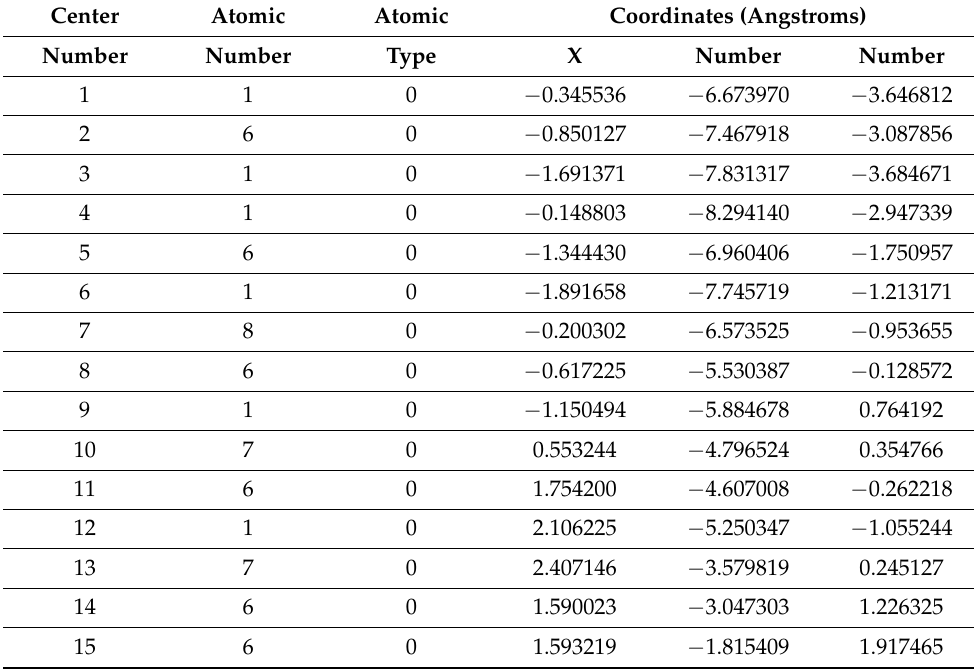
Table A17. Complex MgI 3 LiII 2 with nucleotide triplet